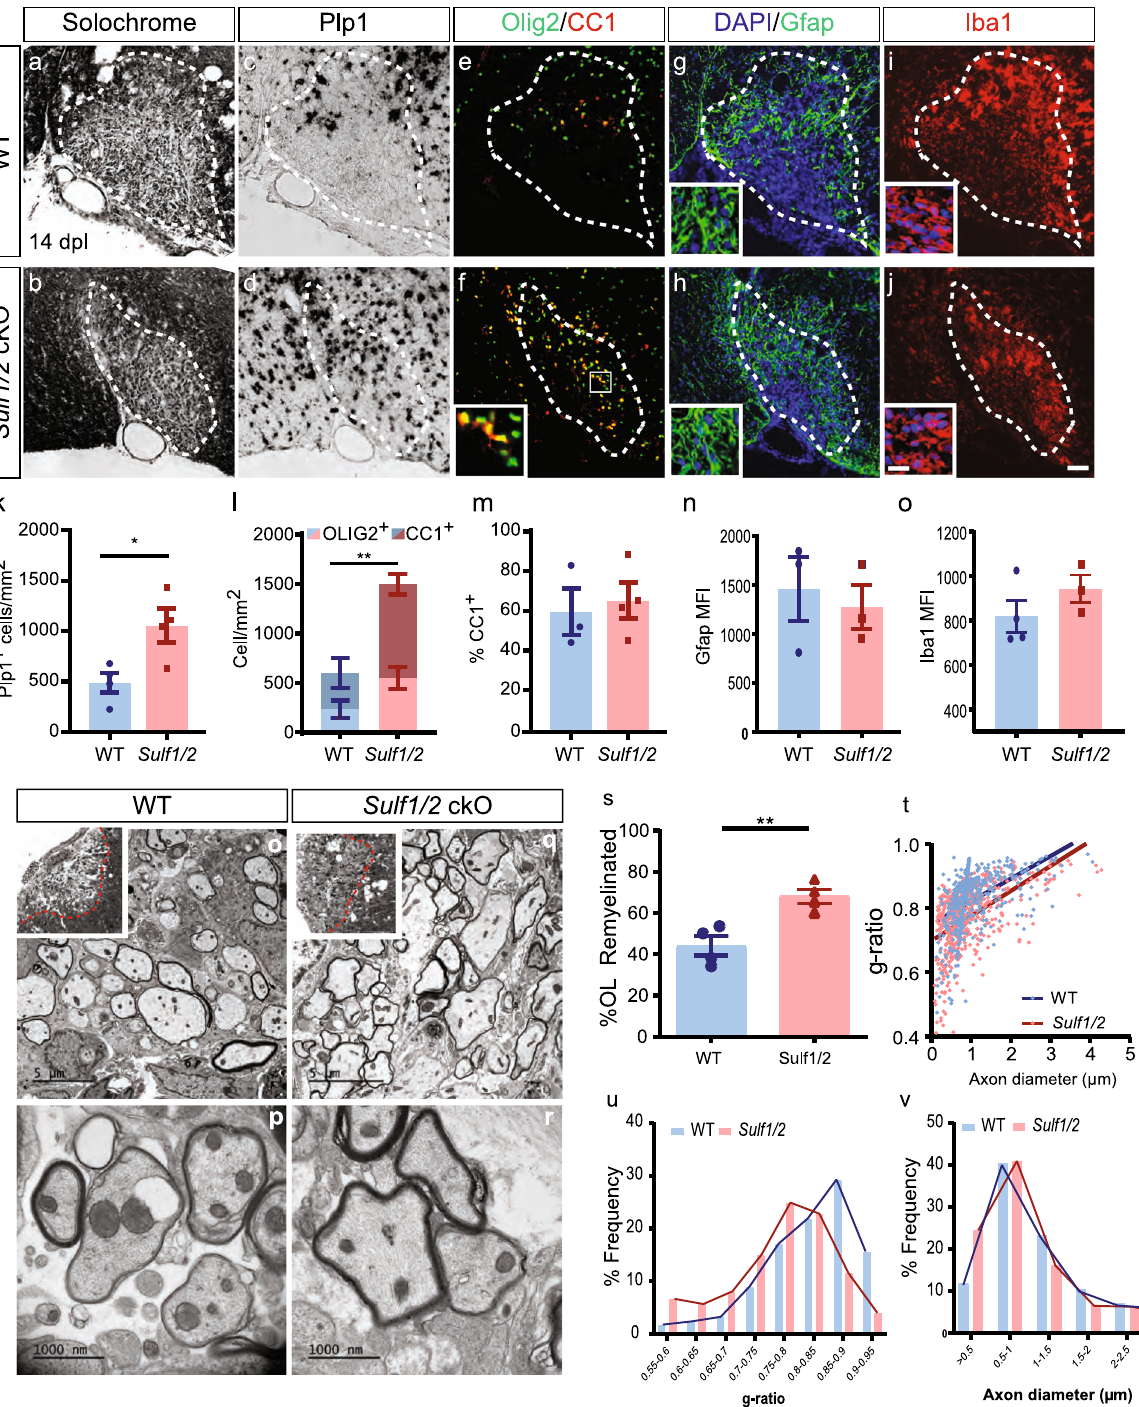
Fig. 4 Conditional ablation of Sulf1/2 accelerates remyelination. a , b Solochrome cyanine-stained lesions at 14 days post lesion (d.p.l.). Oligodendrocyte differentiation was assessed by Plp1 ISH ( c , d ) and Olig2 + CC1 + immuno fl uorescence (Olig2, green; CC1, red) ( e , f ). Astrogliosis was assessed by Gfap (green) and image insert shows a higher magni fi cation image to show morphology ( g , h ), and the microglial responses were assessed by Iba1 (red) and image insert at higher magni fi cation showing morphology ( i , j ). Quanti fi cation of Plp1 + oligodendrocyte cell density ( k ) (*indicates two-sided t test p = 0.026; n = 4 mice per group), Olig2 + and CC1 + density ( l ) (**indicates total Olig2 + density two-sided t test p = 0.0077; n = 4 mice per group), and percentage of CC1 + cells within the Olig2 population ( m ) ( n = 3 and 4 mice, for WT and Sulf1/2 cKO, respectively). n Mean fl uorescence intensity (MFI) of Gfrap ( n = 3 mice per group) and Iba1 cells in lesion ( n = 4 and 3 mice, for WT and Sulf1/2 cKO respectively). o – v Analysis of remyelination by electron microscopy at 14 d.p.l. o , q Inserts show lesion location within ventrolateral white matter. s Proportion of remyelinated axons (**indicates two-sided t test p = 0.0061) and t relationship between axon diameter and g -ratio (linear regression is shown). Frequency distribution of axonal g -ratio ( u ) and axon diameter ( v ) in lesion ( n = 4 mice/group, ≥ 400 axons). Mean ± SEM shown. Scale: 20 μ m ( a – j ) and 5 μ m ( o , q ) and 1000 nm ( p , r